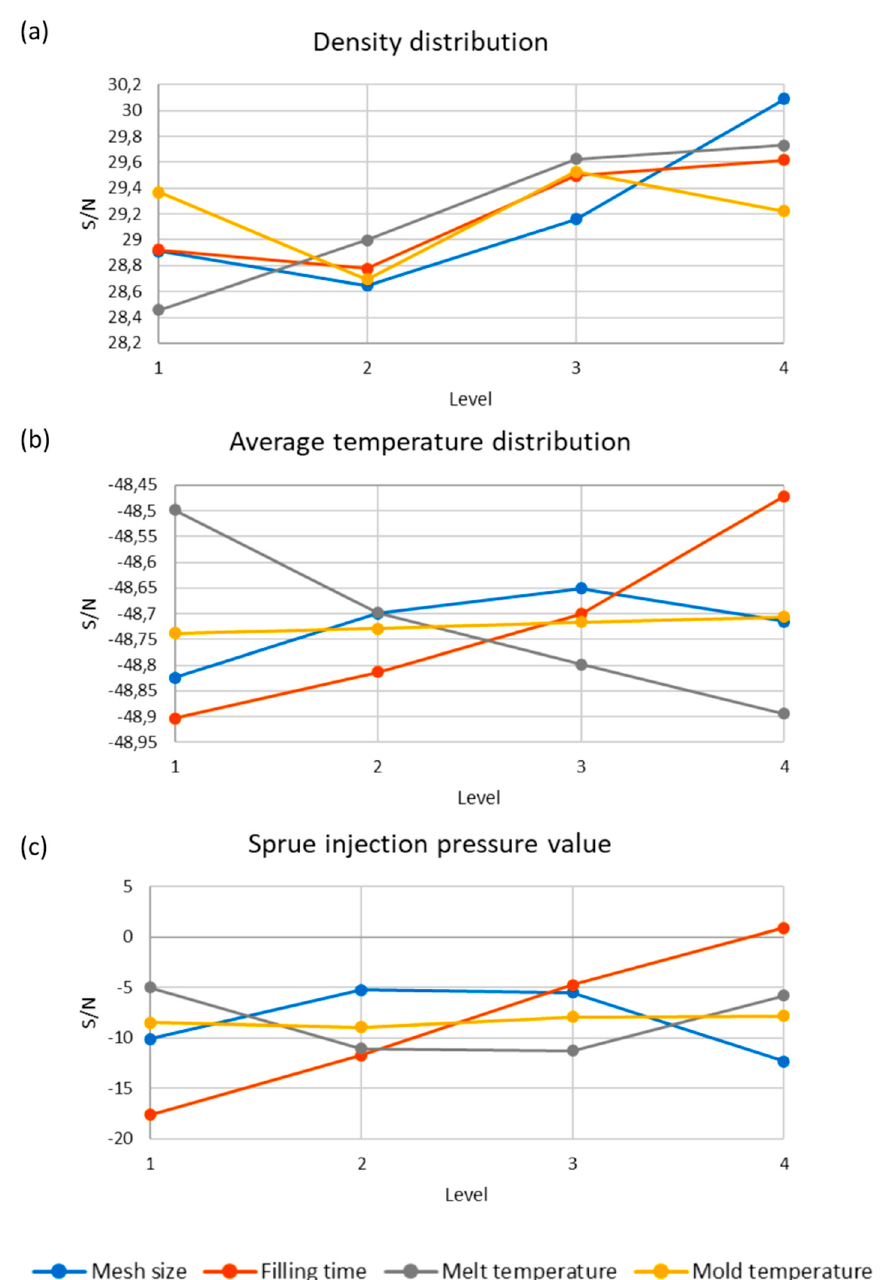
Figure 7. Signal-to-noise (S / N) response curves for various control factors: ( a ) density distribution, ( b ) average temperature distribution, ( c ) sprue injection pressure.